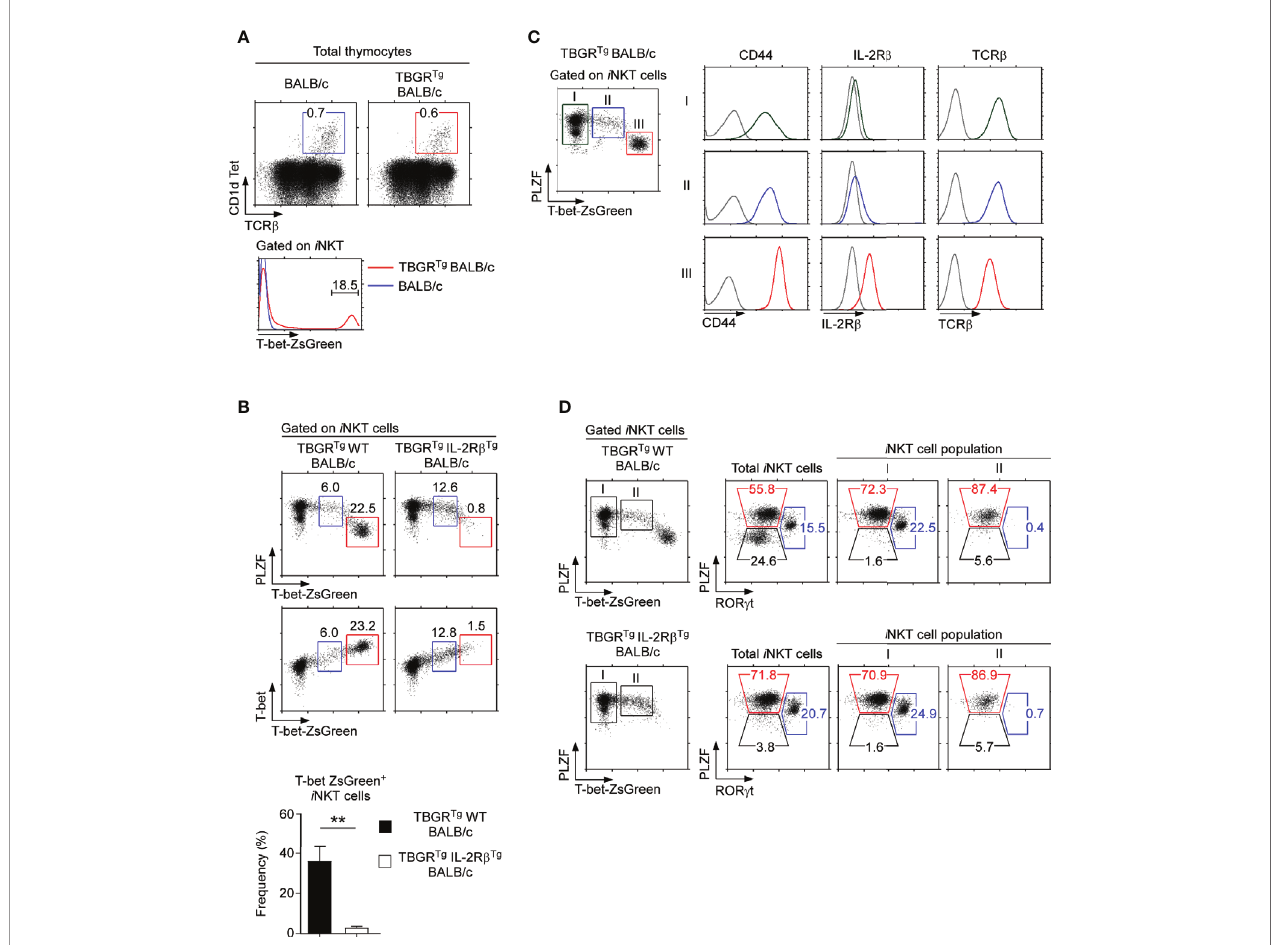
FIGURE 5 | T-bet-ZsGreen reporter expression in i NKT cells of IL-2R b Tg BALB/c mice (A) Thymic i NKT cells were identi fi ed in BALB/c and TBGR Tg BALB/c mice (top) and assessed for T-bet-ZsGreen reporter expression (bottom). Results are representative of 5 independent experiments. (B) T-bet-ZsGreen reporter expression in thymic i NKT cells of TBGR Tg IL-2R b Tg BALB/c and TBGR Tg littermate control mice. Dot plots show either PLZF versus T-bet-ZsGreen reporter expression (top) or T-bet protein versus T-bet-ZsGreen reporter expression (bottom) in HSA lo thymic i NKT cells of TBGR Tg IL-2R b Tg BALB/c and TBGR Tg WT littermate mice. Bar graph shows the frequency of T-bet-ZsGreen + i NKT cells (red box) of the indicated mice. Results are representative 3 independent experiments with 8 TBGR Tg IL-2R b Tg BALB/c and 5 TBGR Tg littermate WT BALB/c mice. (C) T-bet-ZsGreen reporter expression upon NKT1 cell differentiation. Thymic i NKT cells of TBGR Tg BALB/c mice were divided into three distinct populations, i.e. I, II, and III, based on the amount of T-bet-ZsGreen expression (dot plot, left). Surface expression of CD44, IL-2R b , and TCR b was then assessed for each i NKT population (histograms, right). Results are representative of 2 independent experiments with a total of 6 TBGR Tg BALB/c mice. (D) Subset compositions of thymic i NKT cells in TBGR Tg BALB/c mice based on ZsGreen-reporter expression. Total i NKT cells, T-bet-ZsGreen-negative (population I), and T-bet-ZsGreen-intermediate (population II) i NKT cells were identi fi ed in TBGR Tg WT BALB/c (top) and TBGR Tg IL-2R b Tg BALB/c thymocytes (bottom) and examined for their subset composition based on PLZF versus ROR g t staining. Results are representative of 3 independent experiments with 8 TBGR Tg IL-2R b Tg BALB/c and 5 TBGR Tg littermate WT BALB/c mice. **P <